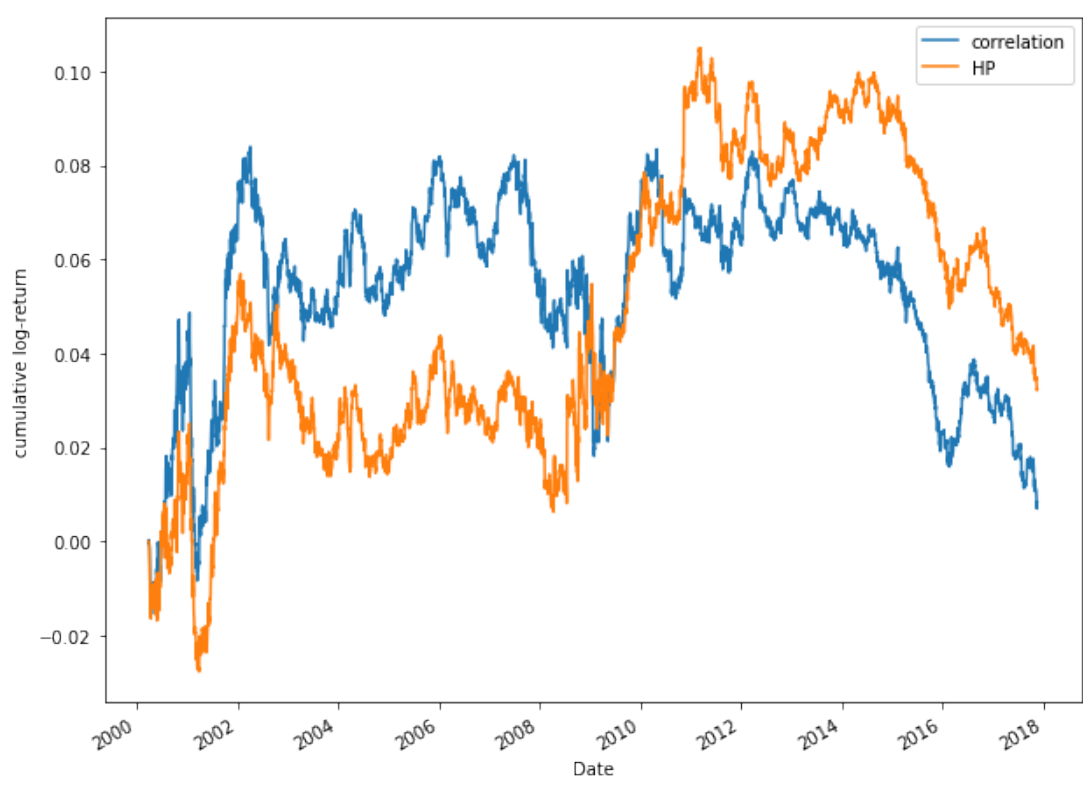
Figure 18. Comparative cumulative log-return of a 20-pair portfolio between HP methods and Pearson’s correlation coefficient, of Dow Jones securities in the period